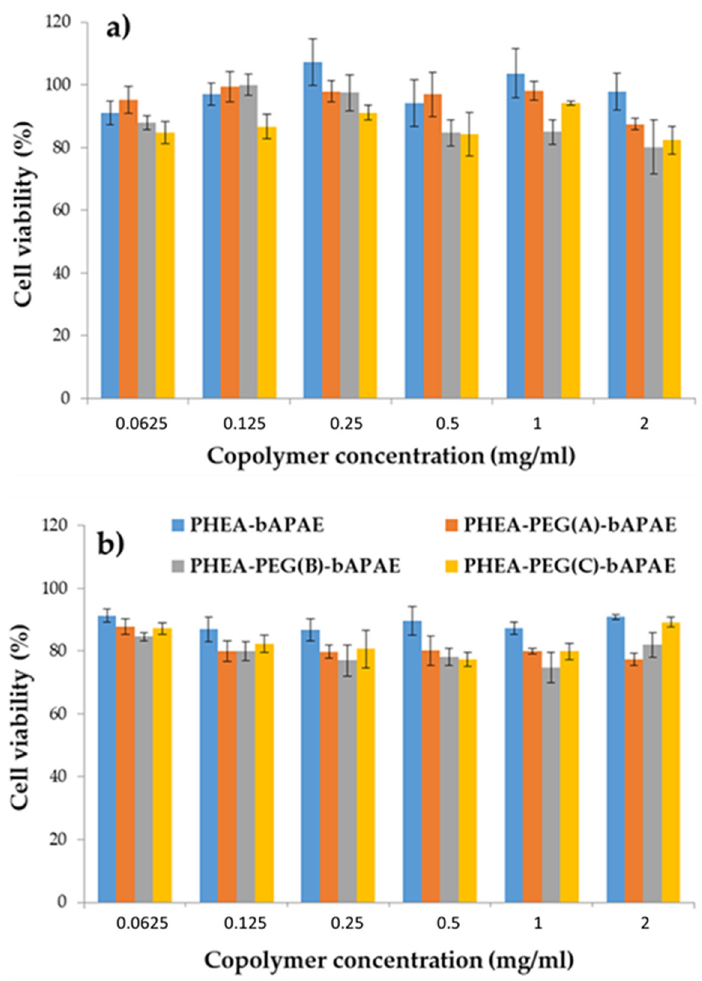
Figure 9. 16 ‐ HBE viability assay after ( a ) 24 and ( b ) 48 h of incubation with all copolymers. Figure 9. 16-HBE viability assay after ( a ) 24 and ( b ) 48 h of incubation with all